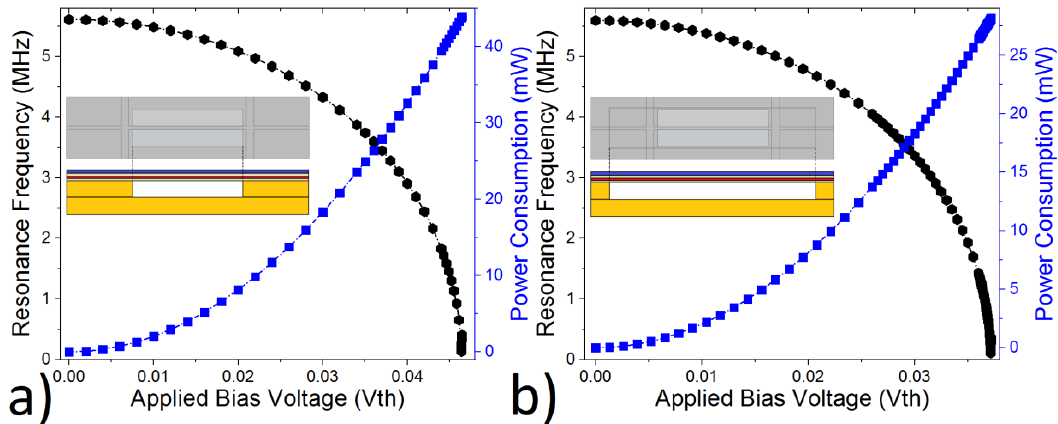
Figure 4. The power consumption and bending voltage for a UniJoule structure (Figure 1b), where ( a ) there is no isotropic on fixed-ends and ( b ) there is a 13 µm isotropic etching on both fixed-ends.